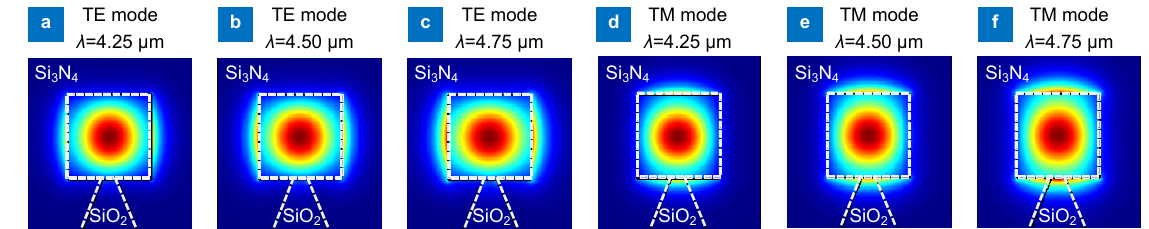
Fig. 5 | Mode profiles of both TE and TM modes at different wavelengths in Ge 0.90 Sn 0.10 waveguide . Figure reproduced from ref. 26 , Optical Society of America.